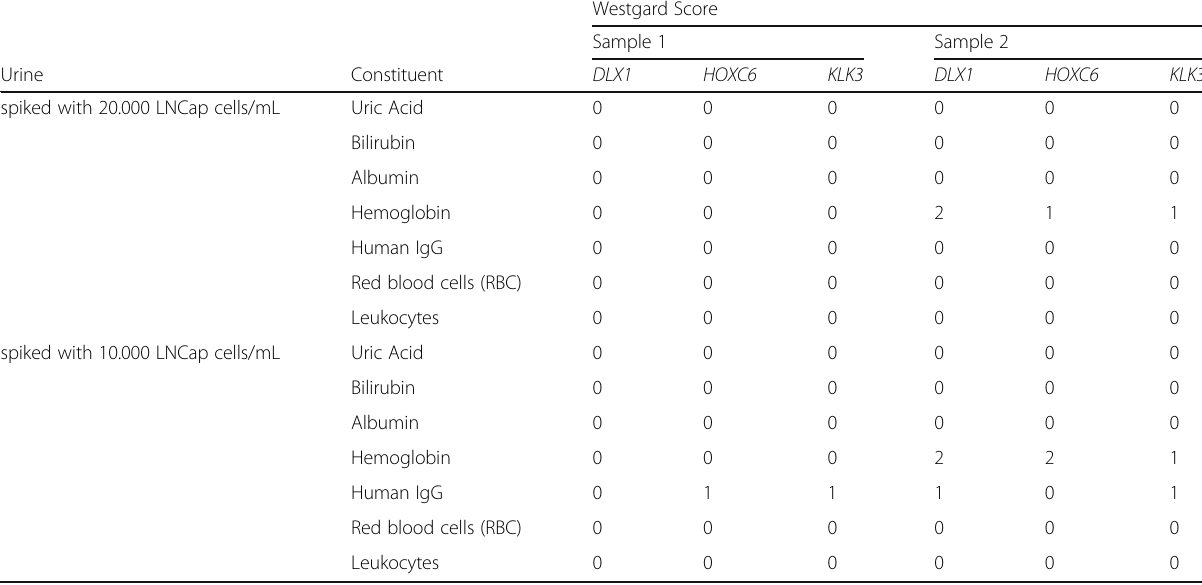
Table 6 Westgard scores for interference testing